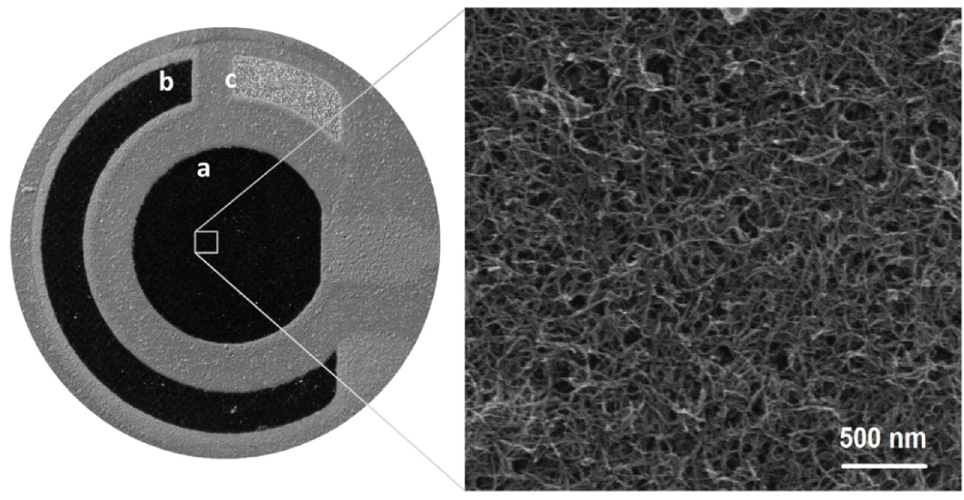
Figure 4. Optical (left side) and scanning electron microscopic (right side) images of SPCE/MWCNTs– COOH